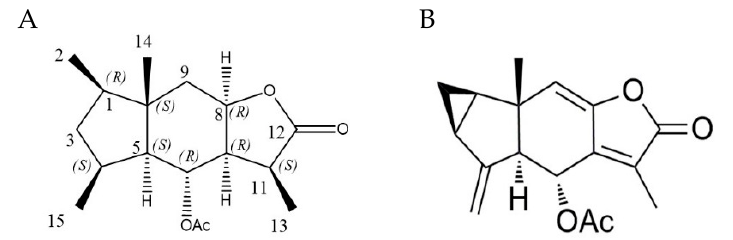
Figure 1. The structures of ( A ) Compound 1 (Perhydrochlojaponilactone B); ( B ) Chlojaponilactone B. 2.2. Neuroprotective Effect of Compound 1 against PC12 Cell Injury Induced by H 2 O 2 PC12 cells were cloned from rat adrenal pheochromocytoma and differentiated into sympathetic nerve cells using nerve growth factor (NGF) stimulation, which have been widely used in studies of neurological diseases [18]. PC12 cell treating with H 2 O 2 is a common model to study oxidative damage, which will cause cell membrane and nuclear damage, the loss of mitochondrial membrane potential (MMP), and the decreased activ- ities of antioxidant enzymes, containing glutathione peroxidase (GSH-Px), superoxide dismutase (SOD), and the cellular glutathione (GSH) content [19–21]. PC12 cells were exposed to different concentrations of compound 1 to determine its cytotoxicity, as assessed using an MTT-based colorimetric test. As shown in Figure 2A, cell viability approached 100% at the concentration of 40 µ M, 20 µ M, 10 µ M, 5 µ M, and 2.5 µ M, suggesting that 1 had no cytotoxicity to PC12 cell. To choose a proper concentration of H 2 O 2, cells were treated with varying concentrations for 24 h. With increasing H 2 O 2 concentration, the cell viability decreased in a linear manner (53.94% at 750 µ M) (Figure 2B). Therefore, we selected 750 µ M H 2 O 2 to induce oxidative damage in at least half of the viable cells. The H 2 O 2 -induced decrease in cell viability was ameliorated dramatically after treatment with 1 in a dose-dependent manner. Cell viability after treatment of 1 at 40 µ M was approaching to that treated with Vitamin C (VC, 10 µ M), which was dramatically enhanced compared to the group induced with H 2 O 2 ( p < 0.05). In particular, 1 displayed a strong anti-oxidative effect at a lower concentration (2.5 µ M) (Figure 2C). These results confirmed the non-cytotoxicity and antioxidant activity of 1 on PC12 cells.